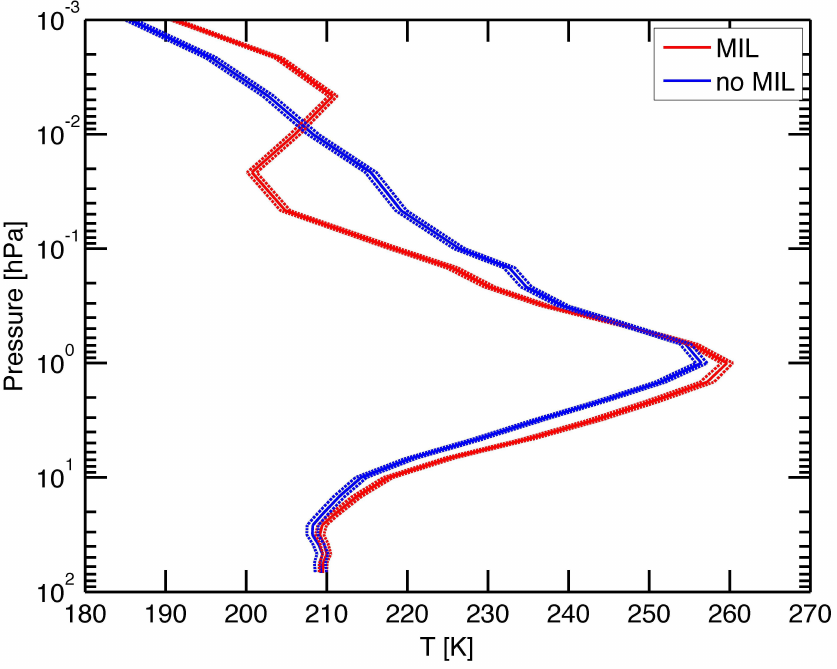
Figure 2. Composites of the temperature profile at Bern, Switzerland when the mesospheric inversion layer (MIL) is present (red) and when the MIL is absent (blue). All the winters (December to February) from 2004/2005 to 2017/2018 of Aura/MLS observations were used for the average temperature profiles. Dashed lines show the error of the